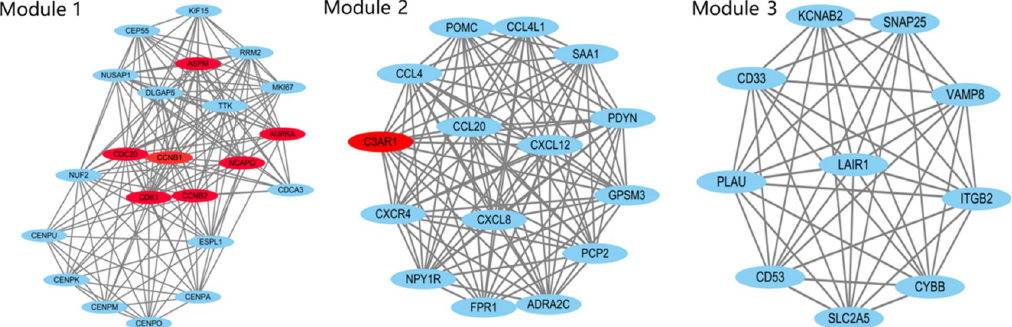
Fig 6. The three most significant modules. Red nodes represent hub GENE analysis by